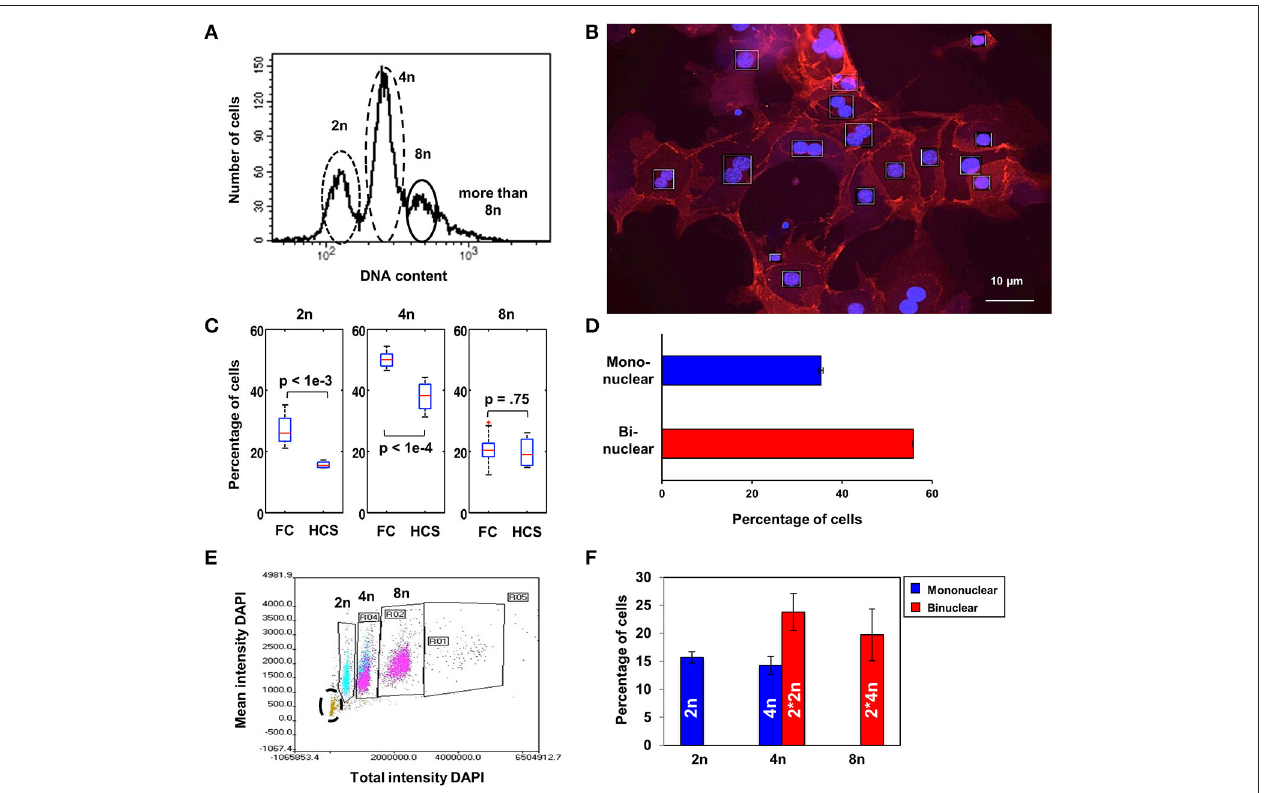
FIGURE 1 | Diploid and polyploid nuclei are equally distributed in hepatocytes with binuclear cells representing the major population. (A) Separation of freshly isolated hepatocytes according to their DNA content by flow cytometry using PI. (B) Representative microscopy image used for the analysis of number of nuclei and amount of DNA per cell by High Content Screening (HCS) in hepatocytes after overnight culture and then staining with anti-ß-catenin and DAPI to determine the amount of DNA relative to the number of nuclei per cell. (C) Comparison of 2n, 4n, and 8n cells analyzed immediately after isolation or after overnight cultivation. There is a significant decrease ( t -test) in the 2n and 4n populations after overnight incubation (HCS) compared to freshly isolated cells (FC). (D) Binuclear hepatocytes are the major population (56%) existing in the liver parenchyma as shown by HCS. (E) Quantification of hepatocytes under correlation with their nuclei number by HCS (those with one nucleus are displayed in blue and those with two nuclei in magenta). Apoptotic cells with very low DAPI intensity (lower left corner, in green highlighted by a black circle) have been excluded from the analysis. (F) Percentage of diploid (2n) and polyploid (4n) hepatocytes in the mono- and binuclear hepatocytes subset after quantitative analysis by HCS. Error bars represent SEM. The dead cells indicated in (E) by the black circle are excluded in (F)